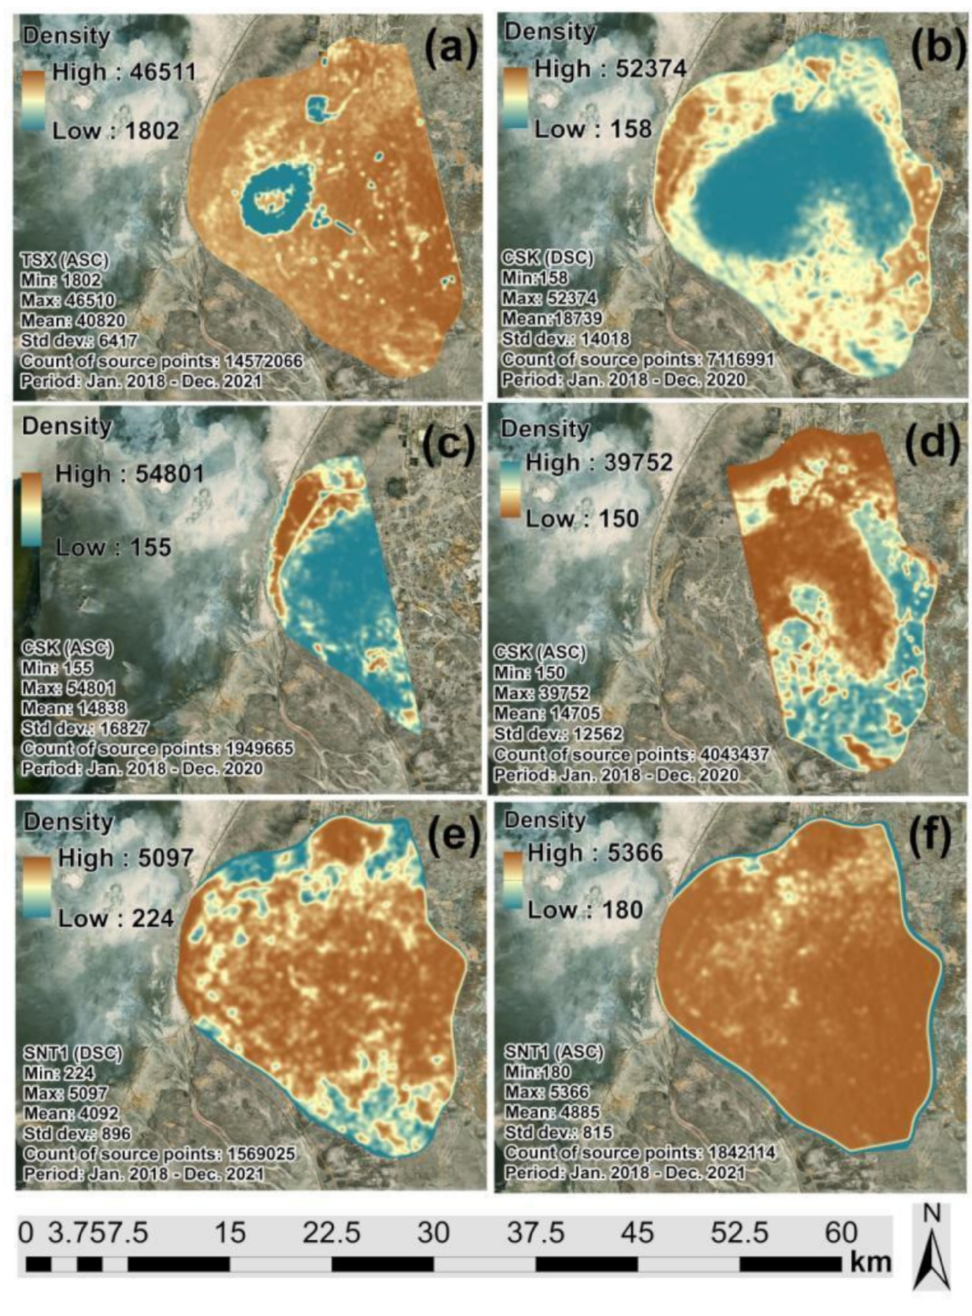
Figure 5. Kernel density grids of SBAS-InSAR measurements using:( a ) TSX (ASC Track); ( b ) CSK (DSC Track); ( c ) CSK (ASC Track 1); ( d ) CSK (ASC Track 2); ( e ) SNT1 (DSC Track); ( f ) SNT1